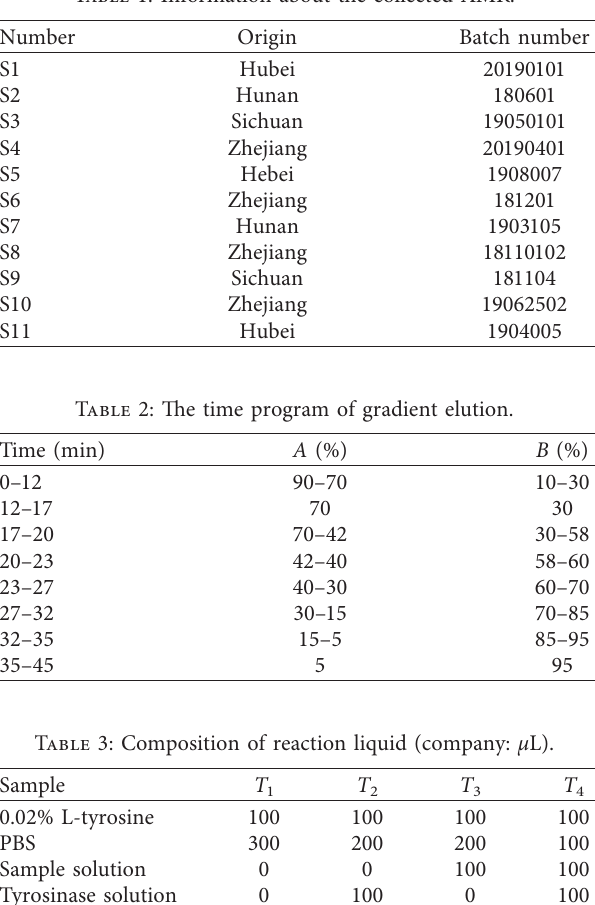
Table 1: Information about the collected AMR.